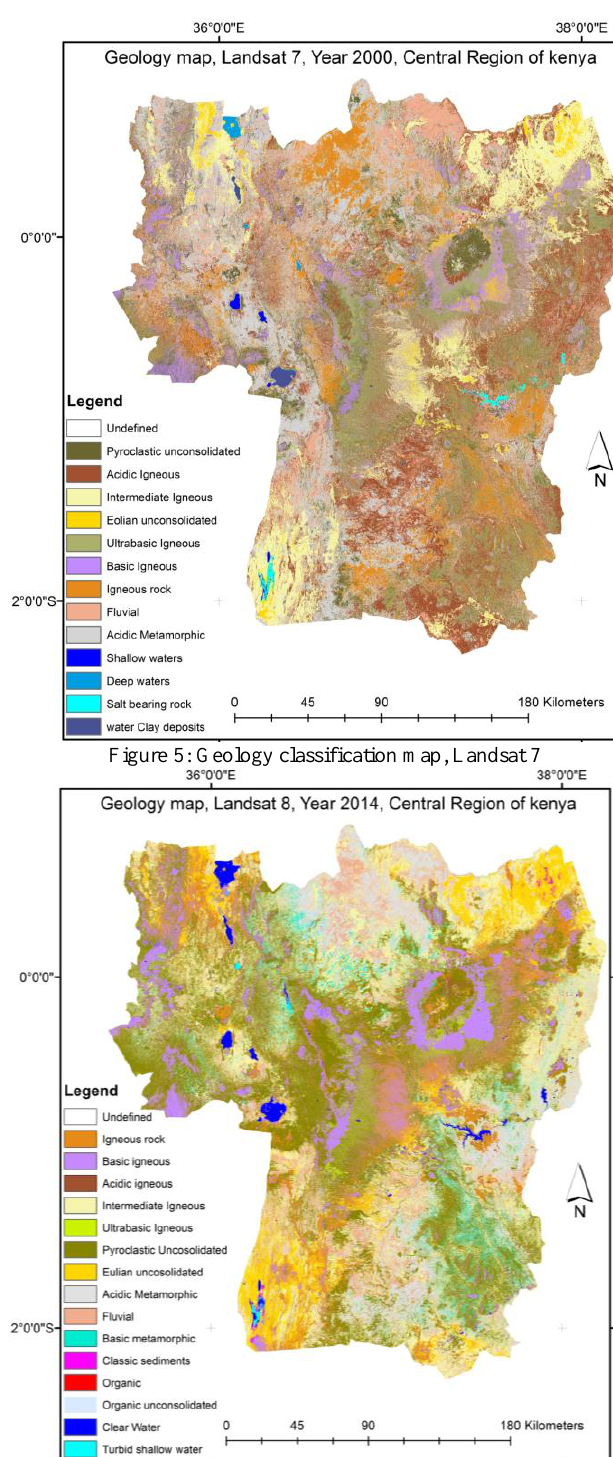
Figure 6: Geology classification map, Landsat 8